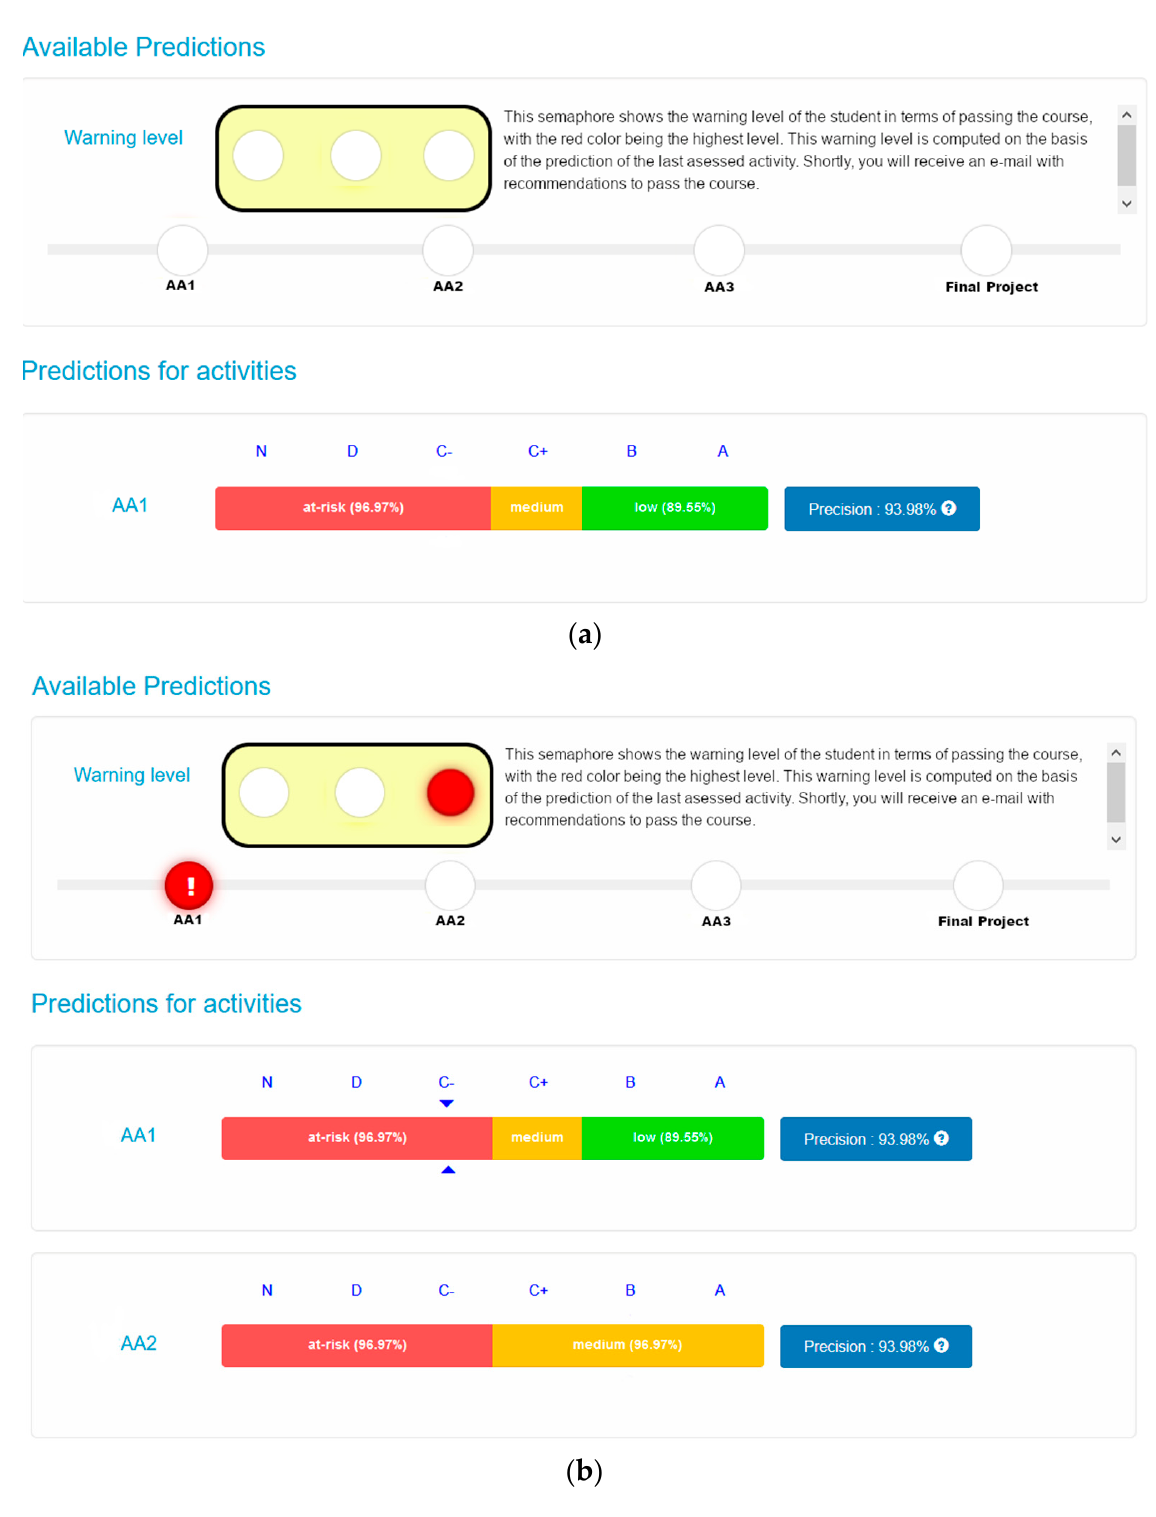
Figure 8. Early warning dashboard for learners ( a ) before performing the AA1 and ( b ) after being graded the AA1.